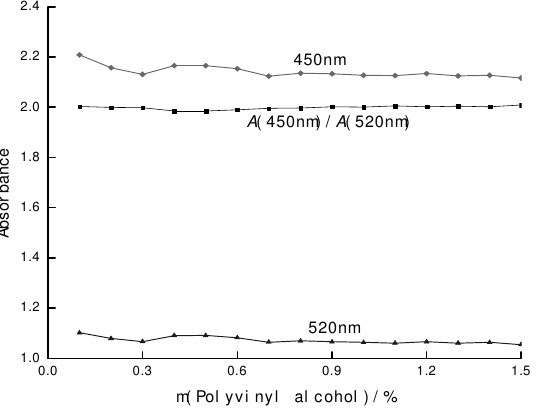
Figure 5. Plots of polyvinyl alcohol mass fraction vs. absorbance of product